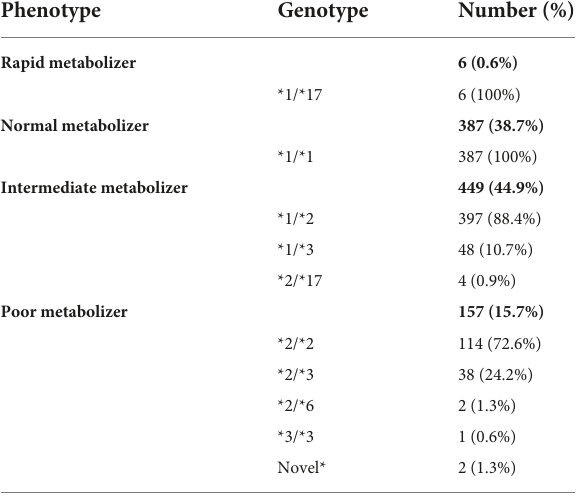
TABLE 1 Genotypes and phenotypes of the